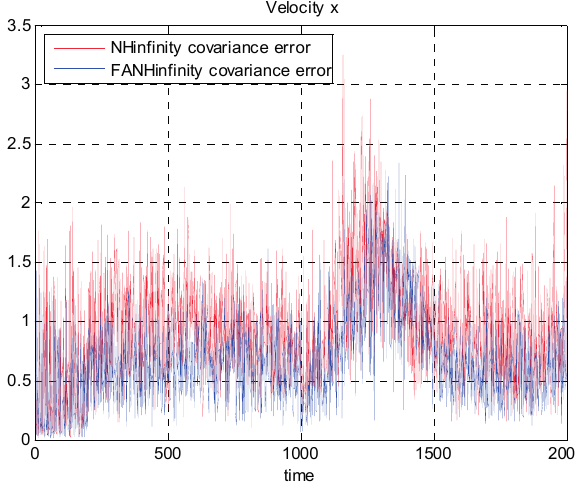
Figure 20. Velocity error covariance in x -axes using the true error.